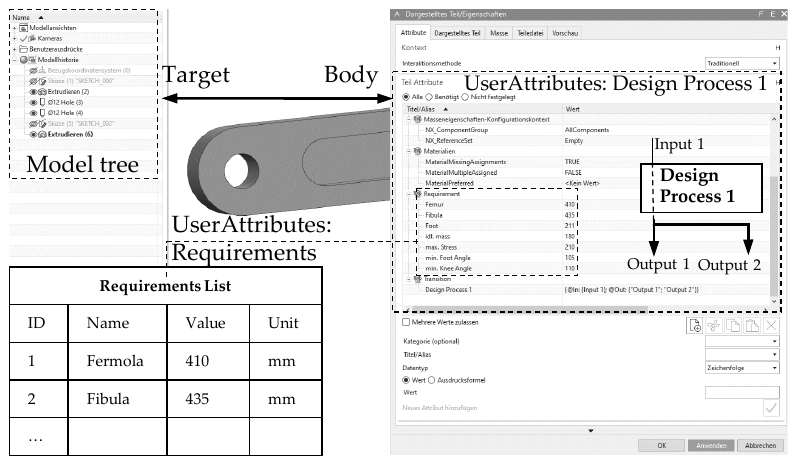
Figure 9. Illustration of the annotation of a new MC Design process including the Requirements, the Design Process of the top level, and the corresponding Input and Output Design Rationales of virtual products in the CAD